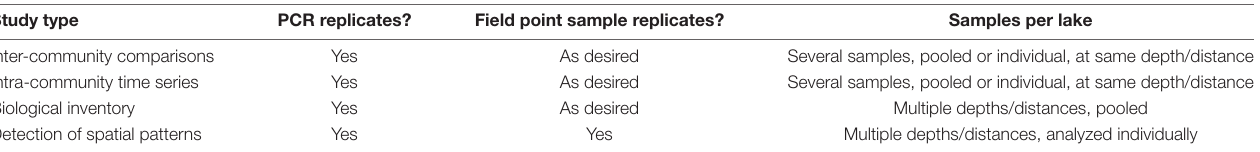
TABLE 5 | eDNA sampling recommendations based on this study of small stratified north temperate